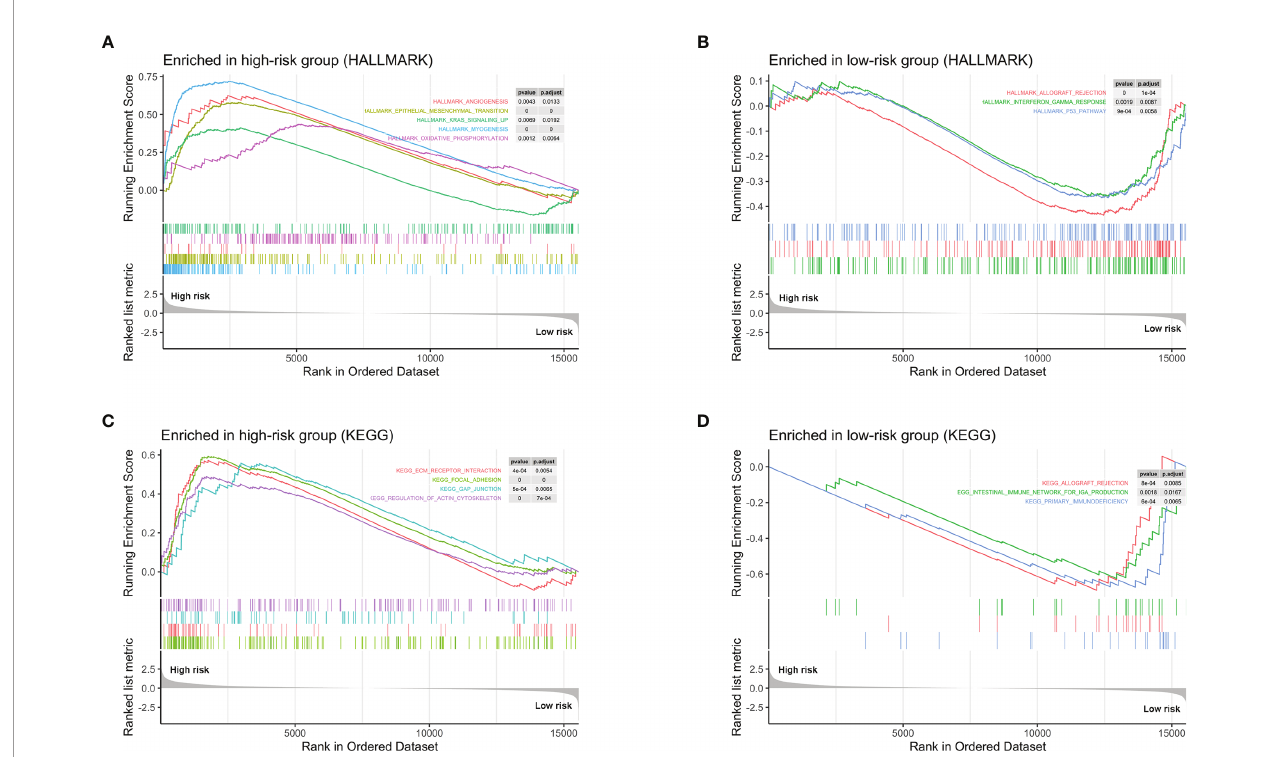
FIGURE 6 | GSEA analysis between high- and low-risk patients determined by the 10-gene prognostic model, in the 52 TCGA-PRAD patients. (A) Hallmark gene sets strongly associated with the 10 prognostic gene in high-risk group. (B) Hallmark gene sets strongly associated with the 10 prognostic gene in low-risk group. (C) KEGG pathways that the 10 genes enriched in high-risk group. (D) KEGG pathways that the 10 genes enriched in low-risk